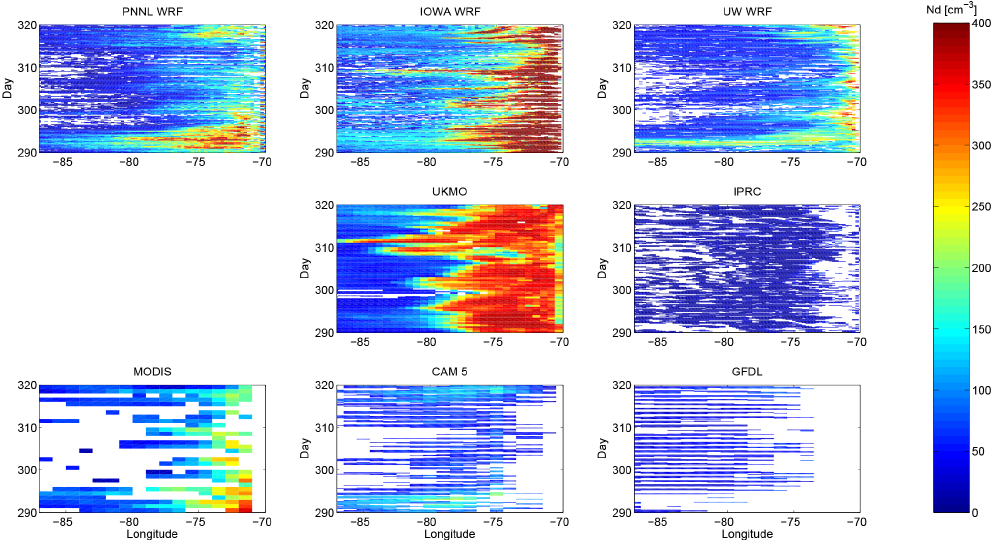
Figure 13. Hovmöller diagrams of the models’ mean cloud droplet concentrations, N d (in cm − 3 ), along 20 ◦ S. Daily mean MODIS estimates from Bretherton et al. (2010) are shown in the lower-left panel.